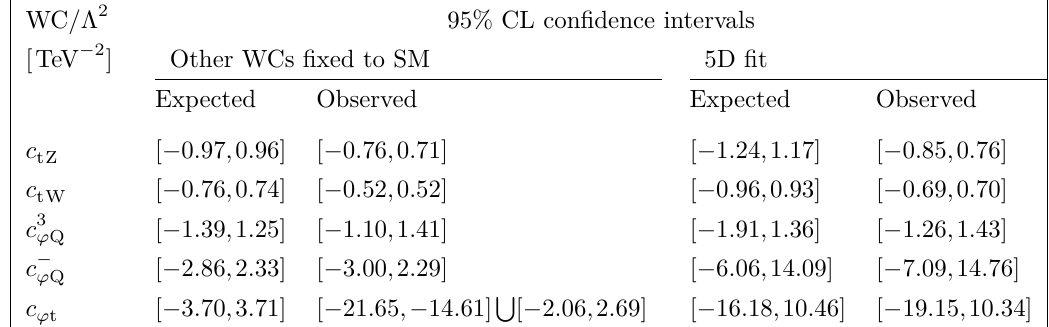
Table 6 . Expected and observed 95% CL confidence intervals for all WCs. The intervals in the first and second columns are obtained by scanning over a single WC, while fixing the other WCs to their SM values of zero. The intervals in the third and fourth columns are obtained by performing a 5D fit in which all five WCs are treated as free parameters. As explained in section 9, the 1D intervals are obtained from separate fits to different observables in the SR- tZq and SR- ttZ , while the 5D intervals are obtained from a single